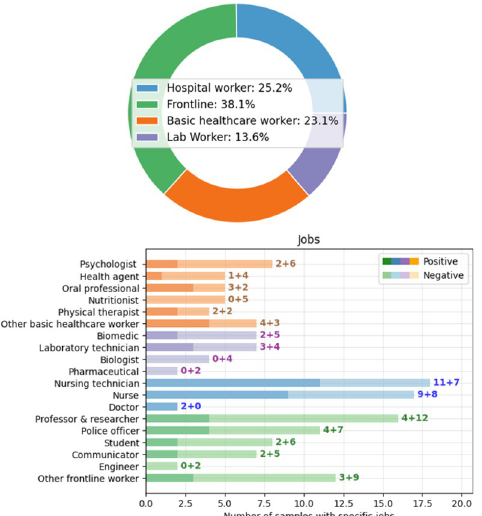
Fig 6. Distribution of categories and jobs on SerumCovid . The positive + negative cases are after each job bar.